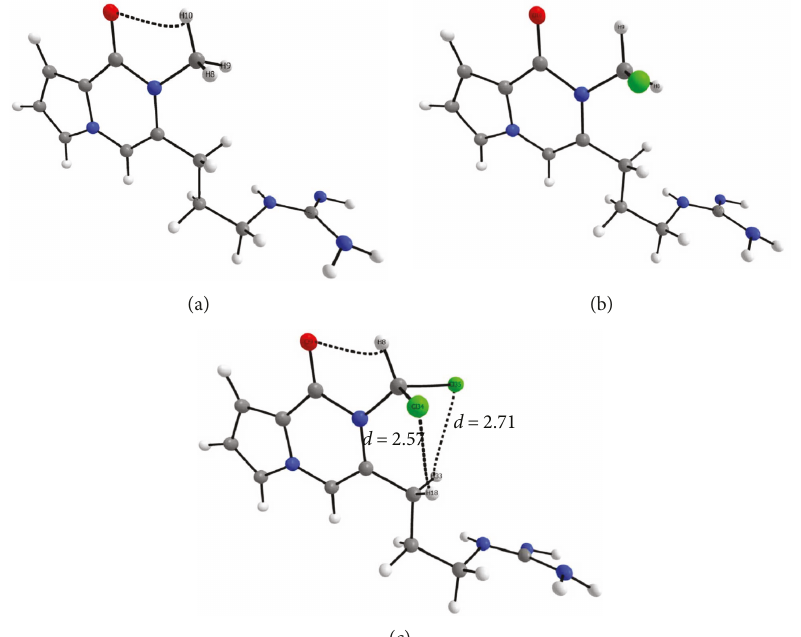
Figure 1: Molecular graphs (representation of bonding interactions according to QTAIM results) of the system analyzed in this study: 23 (a), 22 (b), and 21 (c). The dotted line corresponds to a bond